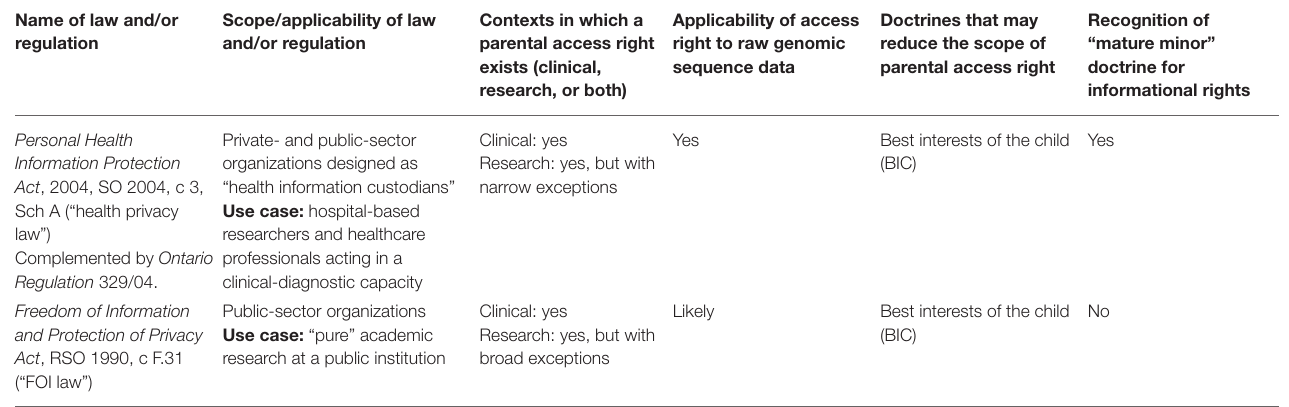
TABLE 1 | Sources and scope of informational access rights in